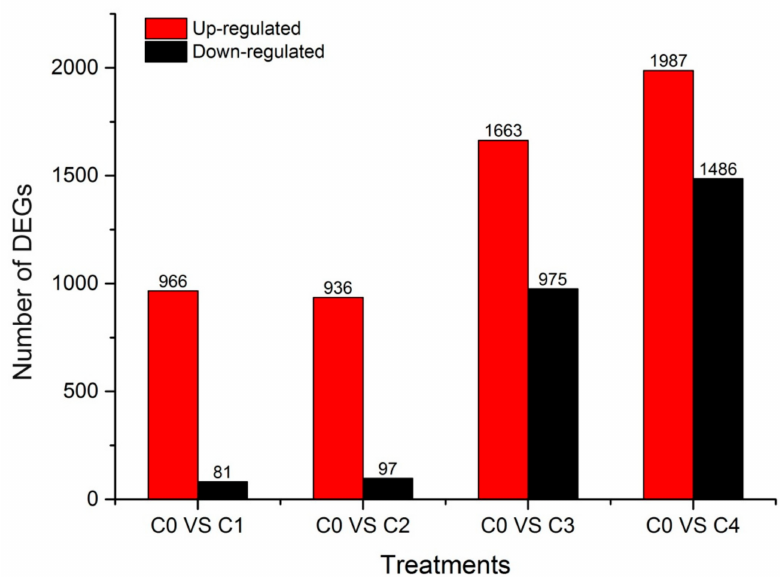
Figure 3. Summary of the differentially expressed unigenes (DEGs). C0, C1, C2, C3, and C4 represent 0, 2, 6, 24, and 48 h, respectively. The red column indicates the up-regulated gene, and the black column indicates the down-regulated gene.